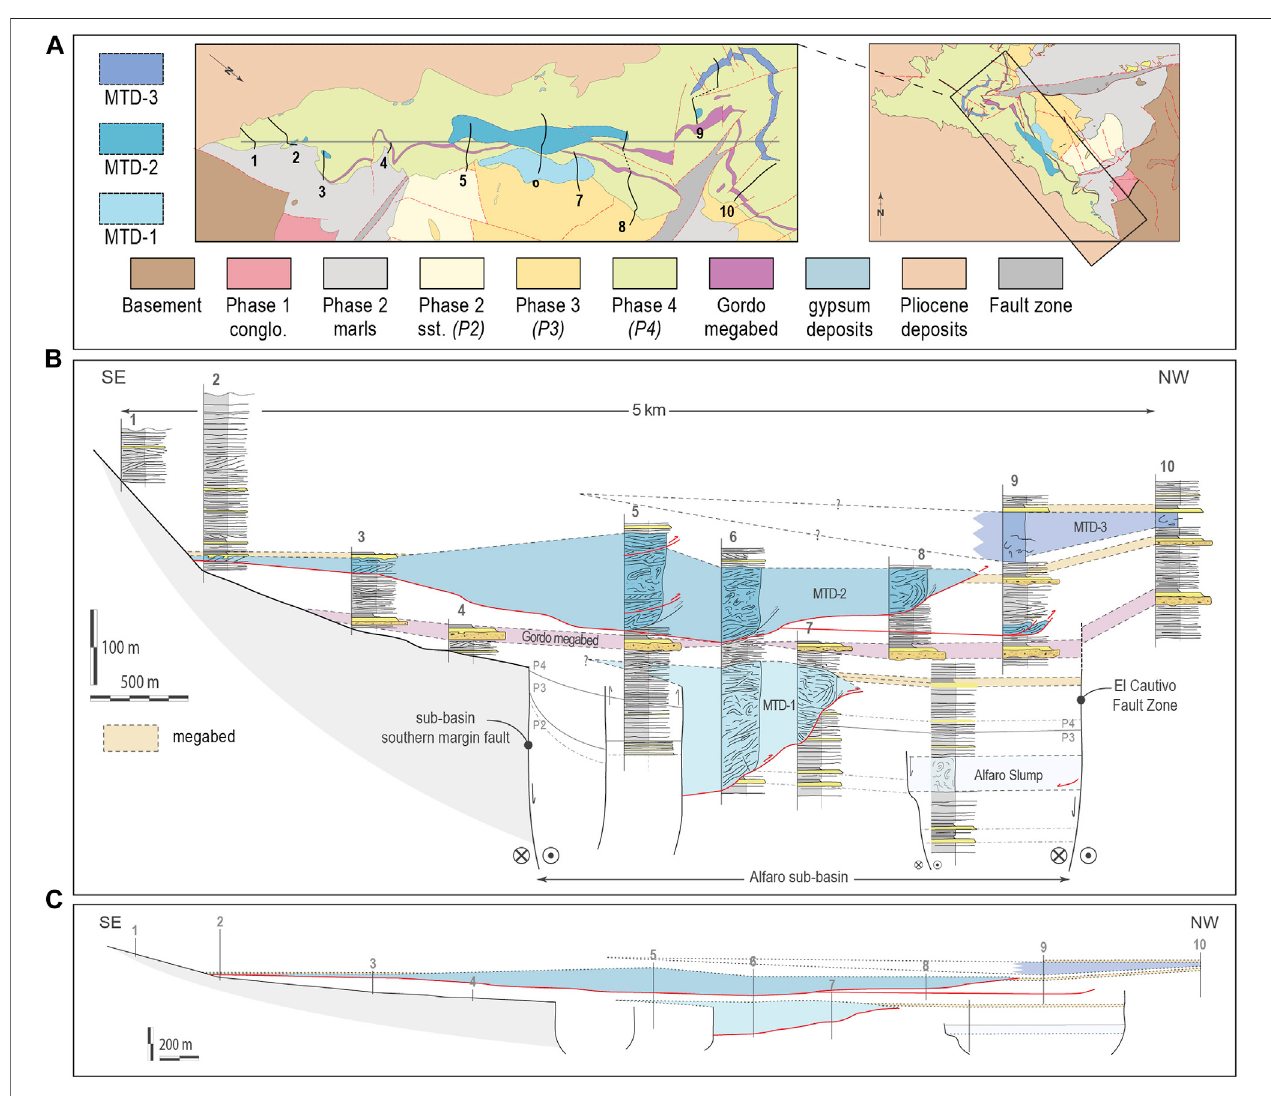
FIGURE10| DistributionandgeometryofMTDsbasedonlogcorrelation (A) Geologicalmapshowingthelocationoftheloggedsections (B) SE-NWorientatedcross- section basedonmappingand log correlation using a verticalexaggeration ofx4 (C) The samecross-section asshown in(B) butwithnoverticalexaggeration.Detachment surfacesarehighlightedinred;relativeshearmovementonthetwosidesofthetectonicfaultsisindicatedbycircles:circlewithdot (cid:1) outofpage;circlewithx (cid:1) intothepage.